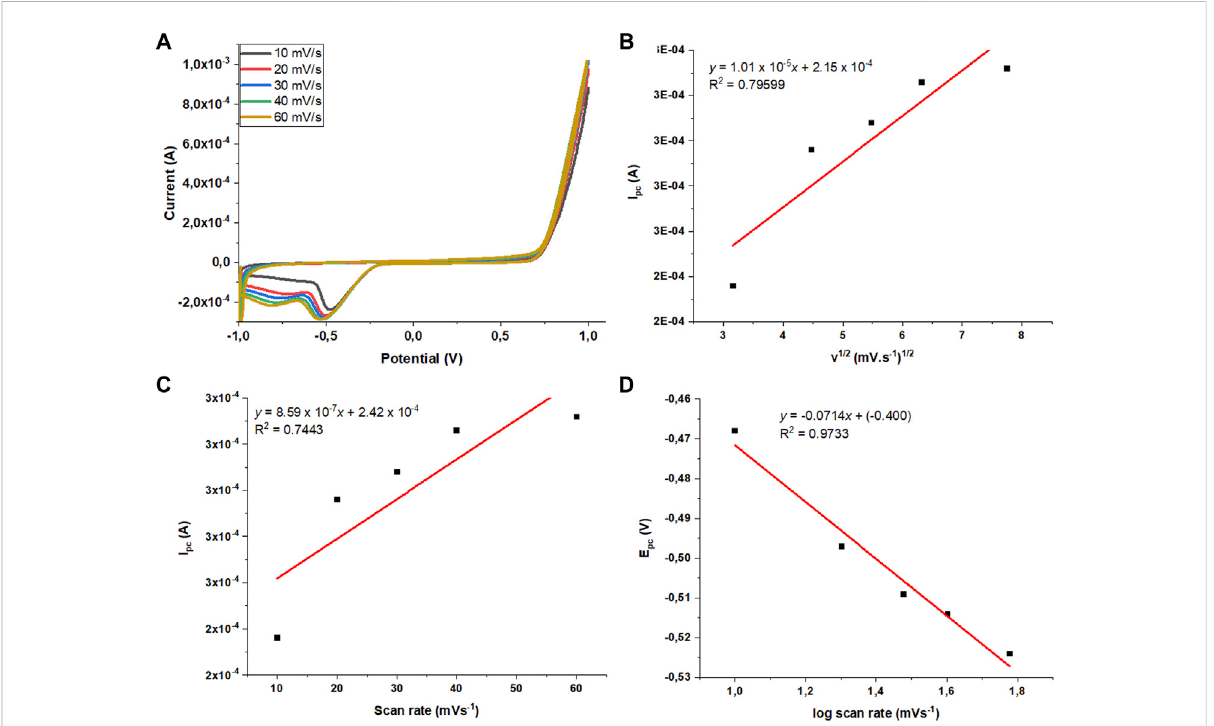
FIGURE 8 (A) Cyclic voltammetry curves obtained at different scan rates for the oxygen reduction peak at BN-CNT-modi fi ed GCE in an unpurged 0.1 M KOHsolution(scanraterangedfrom10to60 mVs − 1 ). (B,C) Plotofthecathodicpeakcurrent versus thesquarerootofscanrate( v 1/2 )andscanrate( v ). (D) Plot of the cathodic peak potential (E pc ) versus log of scan rate (log v